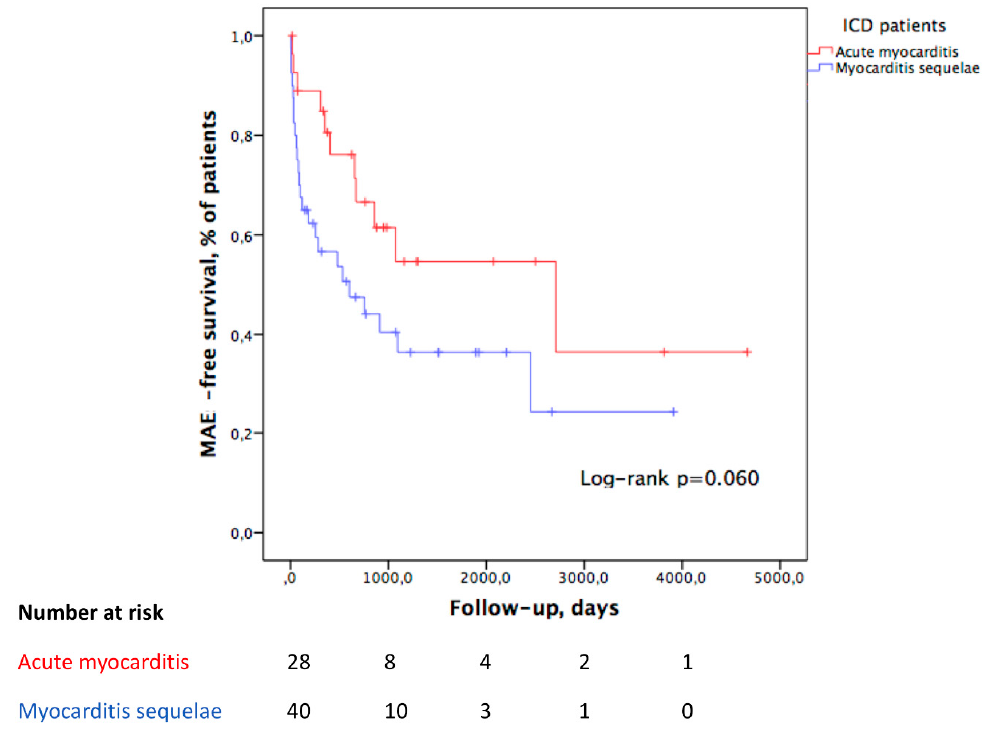
Figure 2. Kaplan–Meier curve comparing survival without major arrhythmic event between acute myocarditis and myocarditis sequelae patients implanted with an